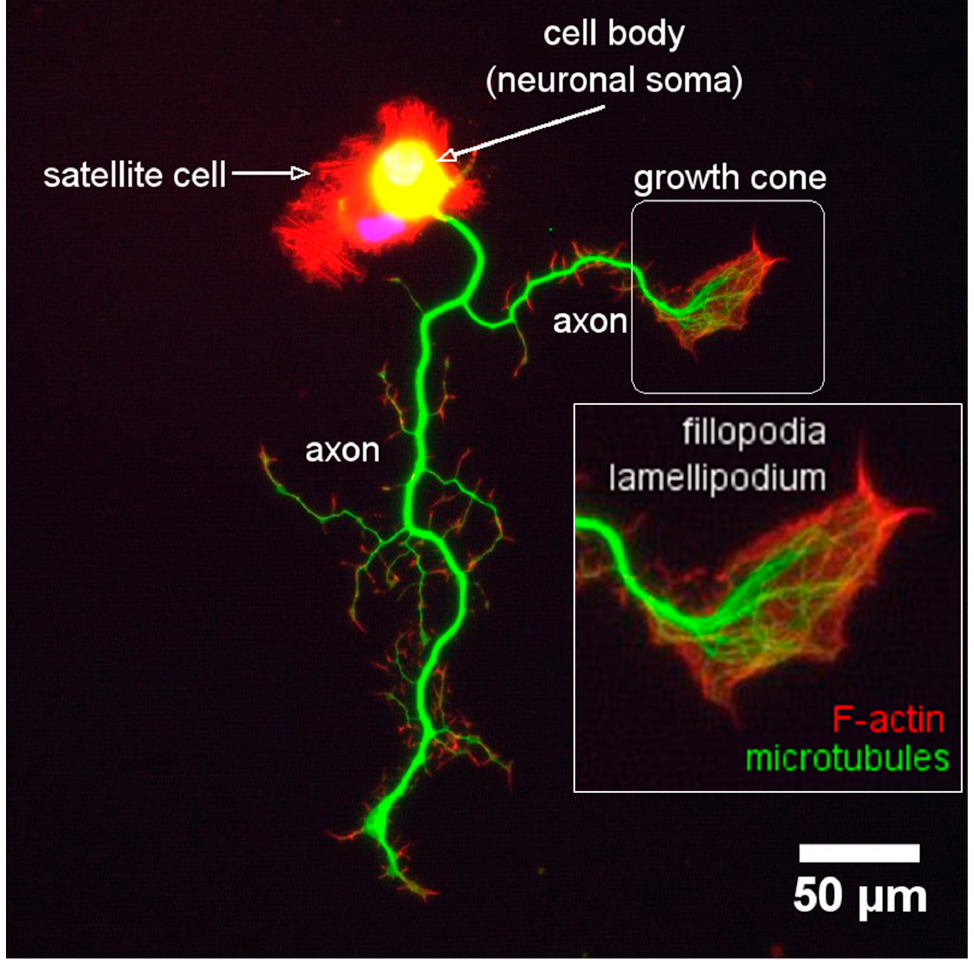
Figure 9. Macrostructure of the growth cone. Image shows an adult murine sensory neuron (left) in culture for 24 h. The neuron is stained with Rhodamine, Phalloidin anti-tubulin- β III, and DAPI to identify filamentous actin (red), neuronal microtubules (green), and the nucleus, respectively. The growth cone (right-corner) is localized at the most distal part of growing neurites and axon. The growth cone is a motile and highly sensitive structure, and two parts characterize its morphology: a broad scattered and flattened structure called lamellipodium, and an extension of sharp-edged peaks called filopodium. Scale bar 50 μ m.